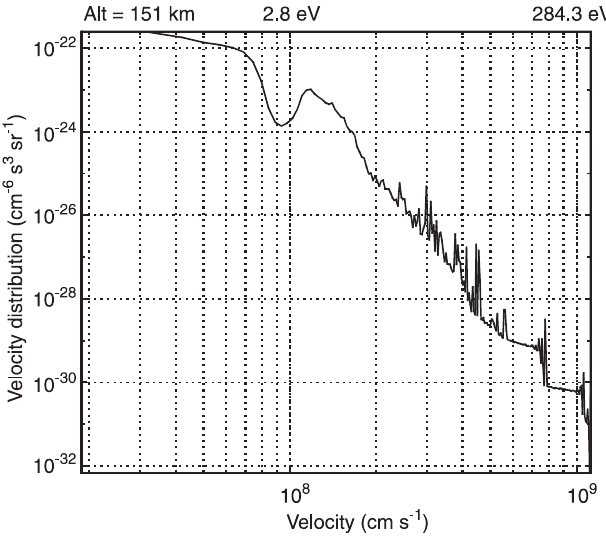
Fig. 2. The suprathermal angular velocity distribution function calculated by the transport code for an eight-stream calculation at 151km and for a pitch angle of 86 (cid:14) (i.e. (cid:108) (cid:136) 0 : 0694). The distribution is nearly isotropic, and the data at the other pitch angles would not be distinguishable on the